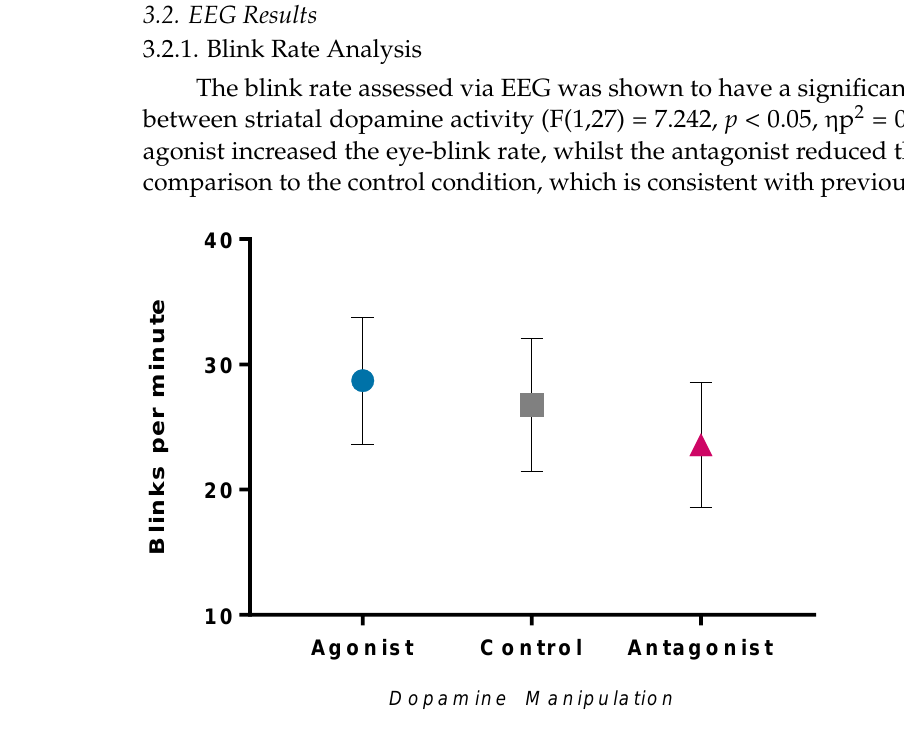
Figure 2. The eye-blink rate (EBR) calculated for each dopamine manipulation condition produced a significant linear relationship between striatal dopamine activity and EBR ( p < 0.05). The D2 receptor agonist increased the EBR and the antagonist reduced the EBR in comparison to the control condition. Data are presented as mean and 95% confidence intervals (cf. [100] ).